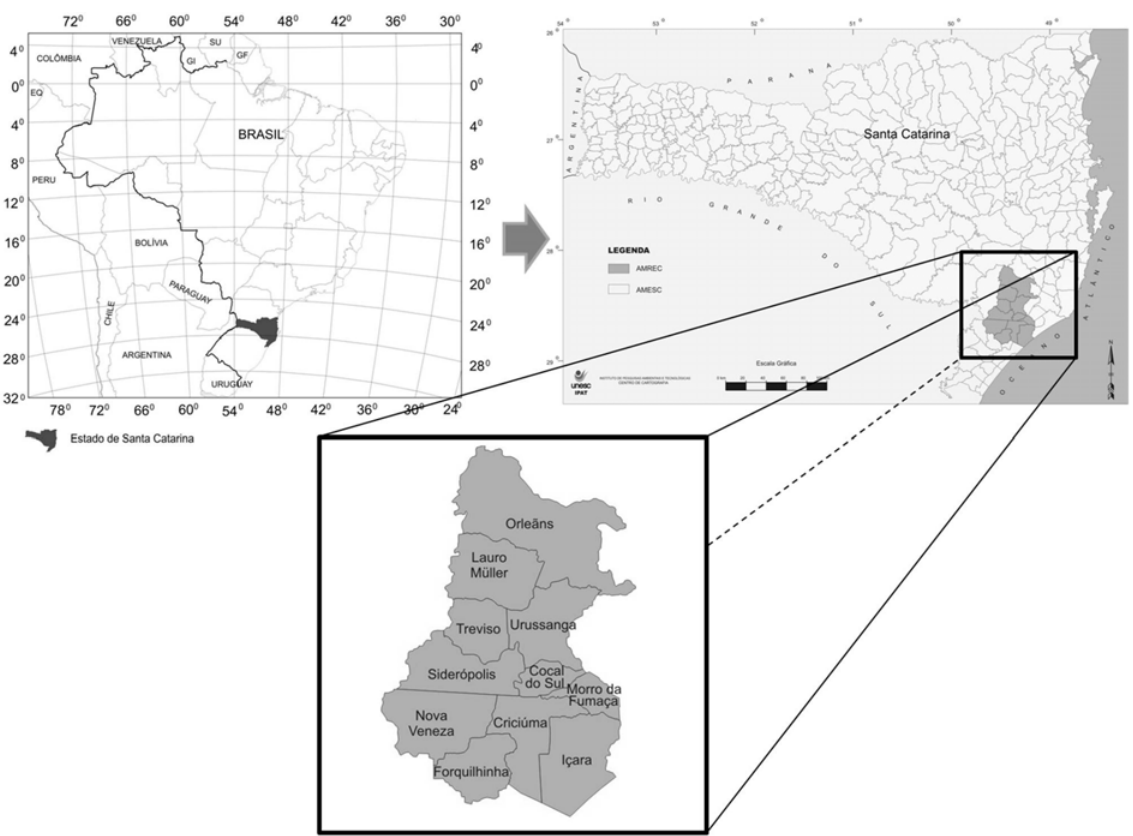
Figure 1. Studied area of honeybee and caterpillar stings. Map of Brazil (above the left); map of Santa Catarina State (above the right), and the map of the 11